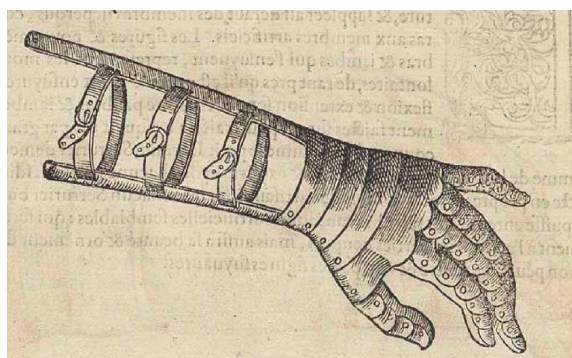
Figure 1: Drawing from barber/surgeon Ambroise Par´e in the 1500s. The prosthetic hand features buckle straps used to suspend the hand by squeezing the residual forearm skin. Compressive suspension remains the fundamental concept in standard modern prosthetic limbs (reproduced with permission courtesy of the National Library of Medicine. Par´e, Ambroise. [Les Oeuvres]. page